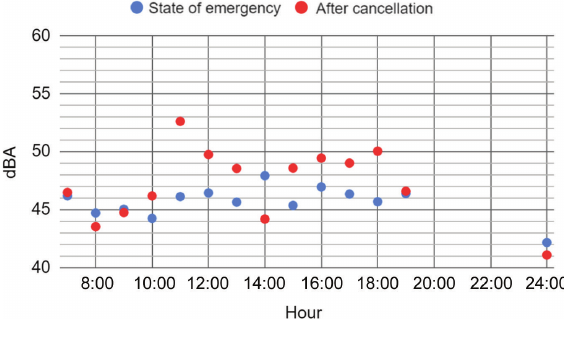
Comparison of the day history of the , T = 30 s) of Saturday noise levels (L Aeq during the state of emergency (16 May 2020) (blue) and after its cancellation (23 May 2020) (red).